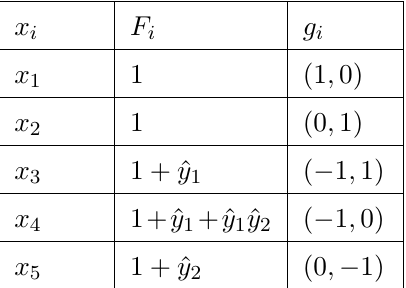
Table 1. The F (ˆ y i ) polynomials and g -vectors of the A 2 cluster